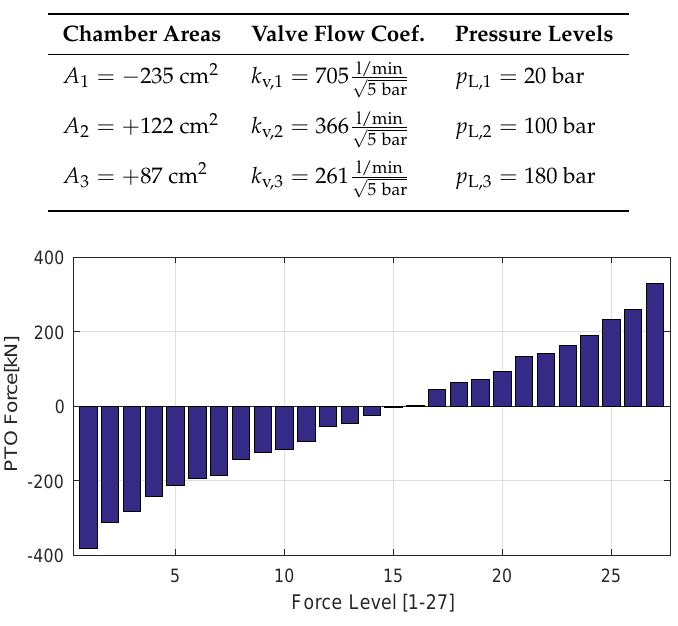
Figure 6. Applicable static force levels for the discrete PTO system.